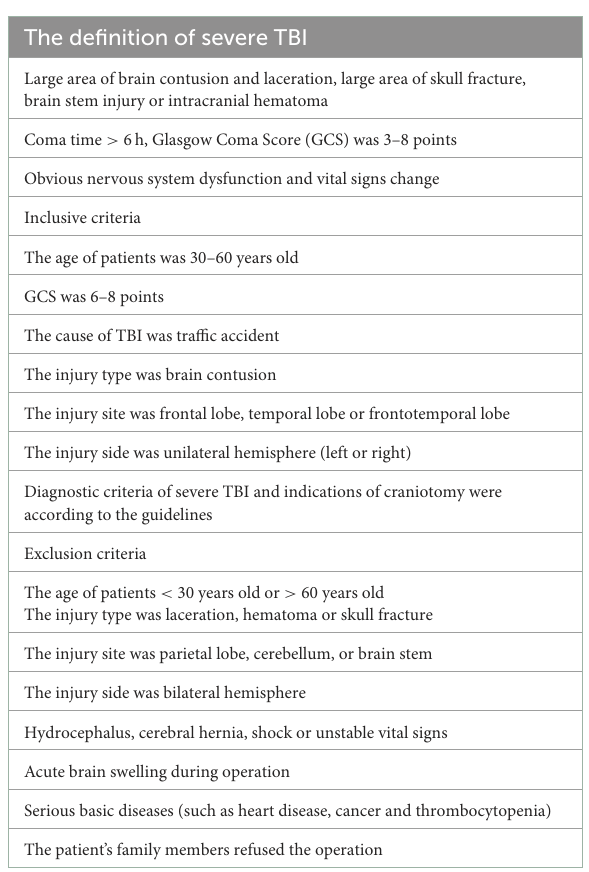
TABLE 2 The definition of severe TBI, inclusive criteria and exclusion criteria in our